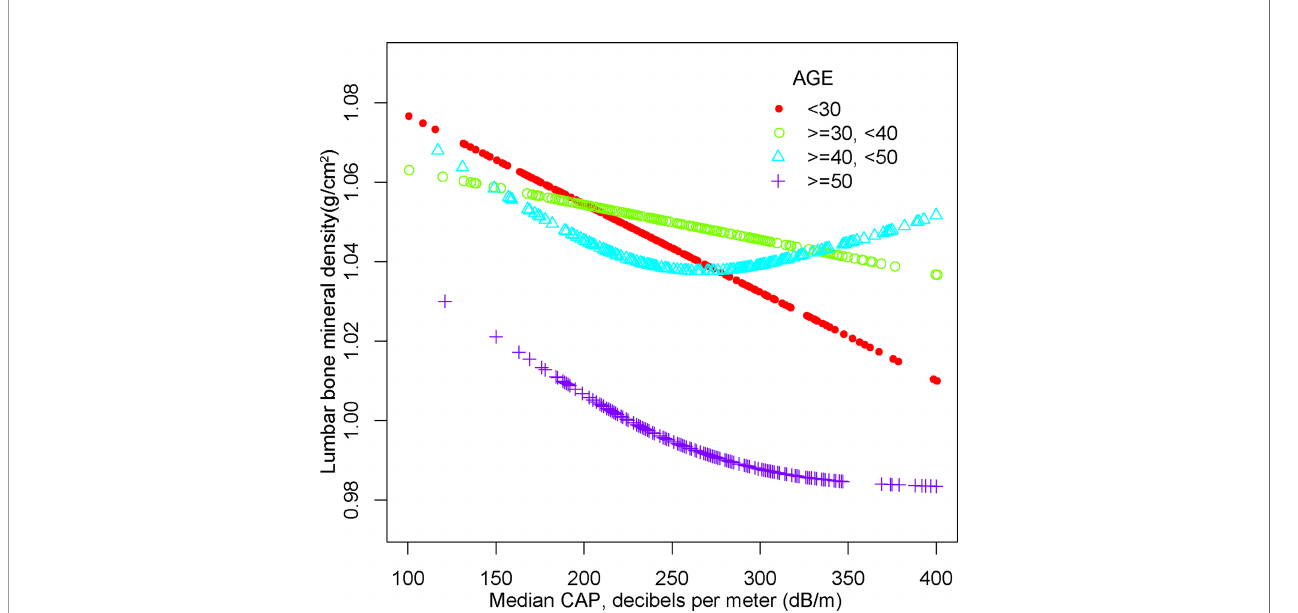
FIGURE 5 | The association between NAFLD and lumbar bone mineral density strati fi ed by age. Age, gender, race, body mass index, poverty to income ratio, education, diabetes status, waist circumference, Glycated hemoglobin, Total cholesterol, Triglyceride, LDL- cholesterol, HDL- cholesterol, ALT, ALP, GGT, AST, Serum creatinine, Serum iron, Lumbar bone mineral density, CAP and LSM were adjusted.